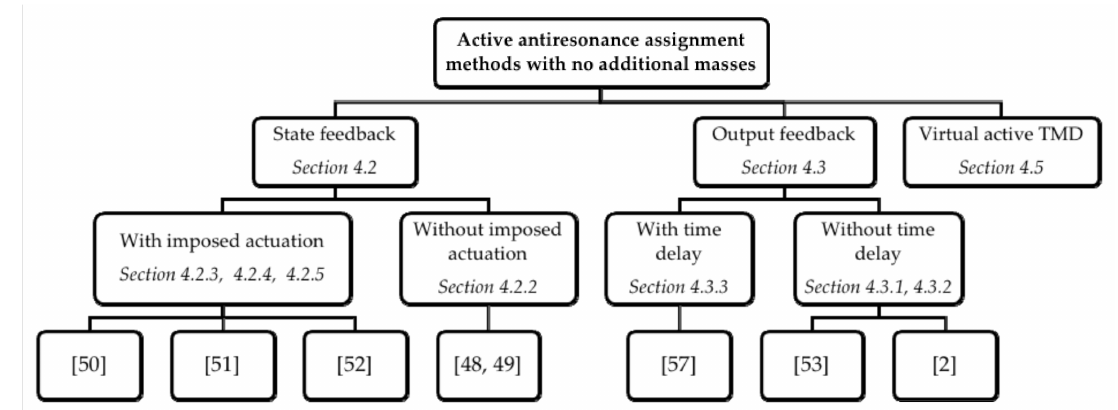
Figure 6. A summary of the active antiresonance assignment methods with no additional